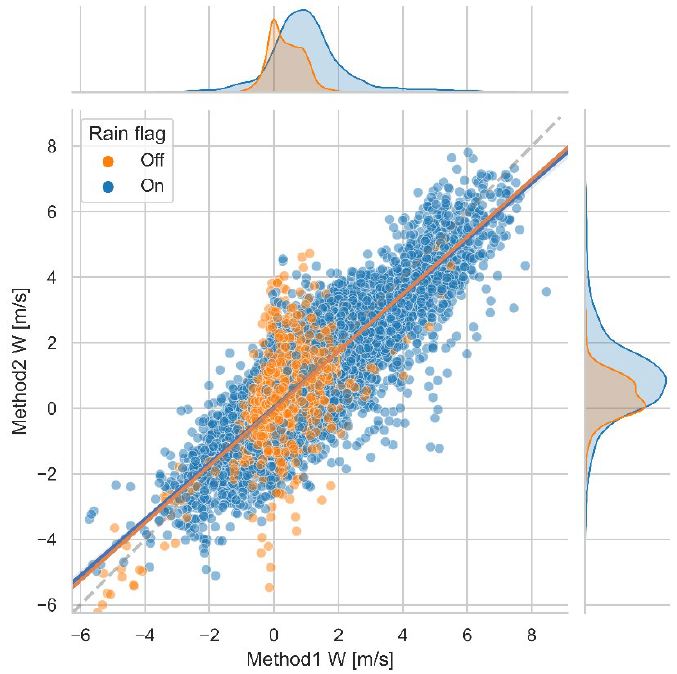
Figure 7. Vertical speed from ALWPP (Method1) vs UBWPP (Method2) showing wind profiler echoes in rainy (20127 samples, in blue) and non-rainy (9693 samples, in orange) conditions, the corresponding linear regression (also in blue and orange) and the diagonal (dashed) line. The top and right panels show the normalized distributions of rainy and non-rainy conditions for Method1 and Method2, respectively.